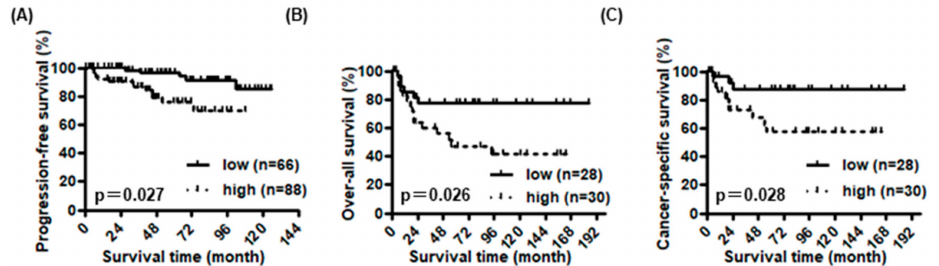
Figure 2. The association between clinicopathological information of the 154 non-muscle invasive bladder cancer(NMIBC)patientsand58muscle-invasivebladdercancer(MIBC)patientsandtheirDAB2expressionin cancer lesions. In NMIBC, there was a significant association between DAB2 expression and progression-free survival ( A ). In MIBC, over-all survival ( B ) and cancer-specific survival ( C ) were significantly lower in patients with high DAB2 expression than that in patients with low DAB2